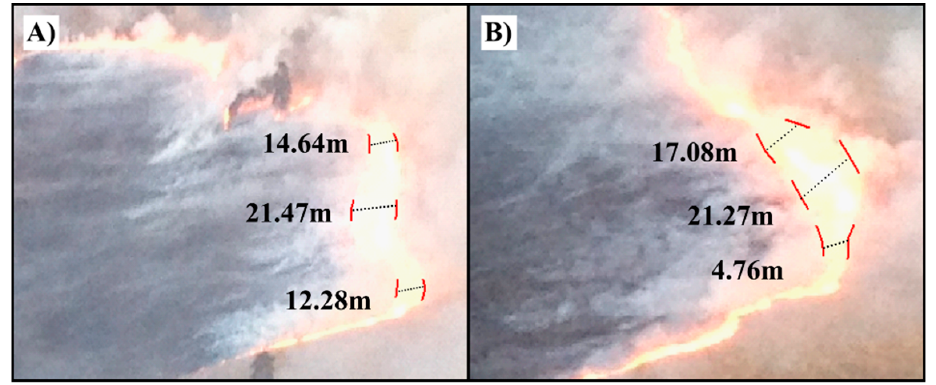
Figure 9. ( A , B ) Two flaming fronts in image 3B, displaying measurable flaming front depths (red).